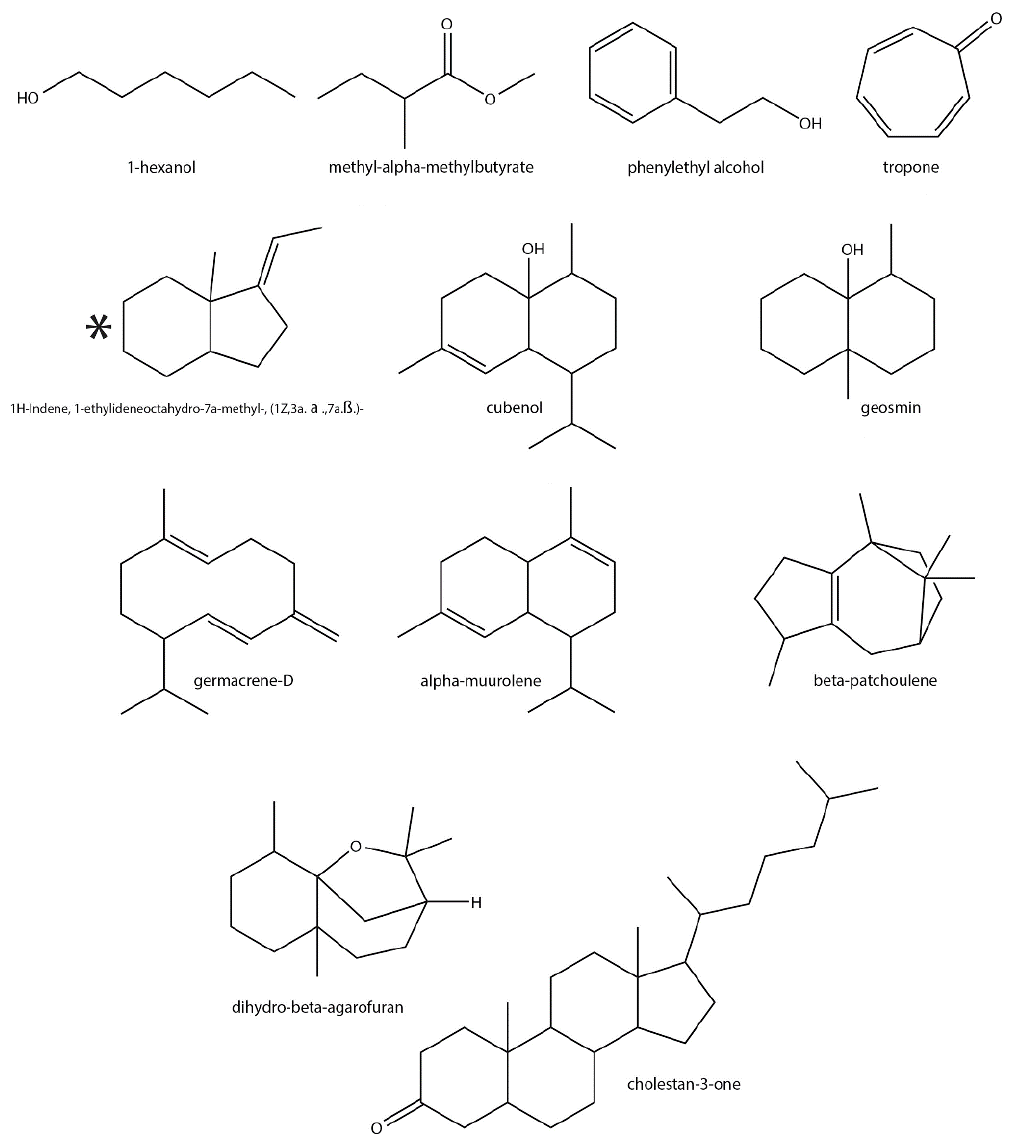
Figure 3. Structures of plant-associated VOCs detected in the current study that have been previously reported from Streptomyces spp. The asterisk (*) indicates that the same spectrum was found in two well-separated peaks, indicating the likely occurrence of two closely related diastereomers.